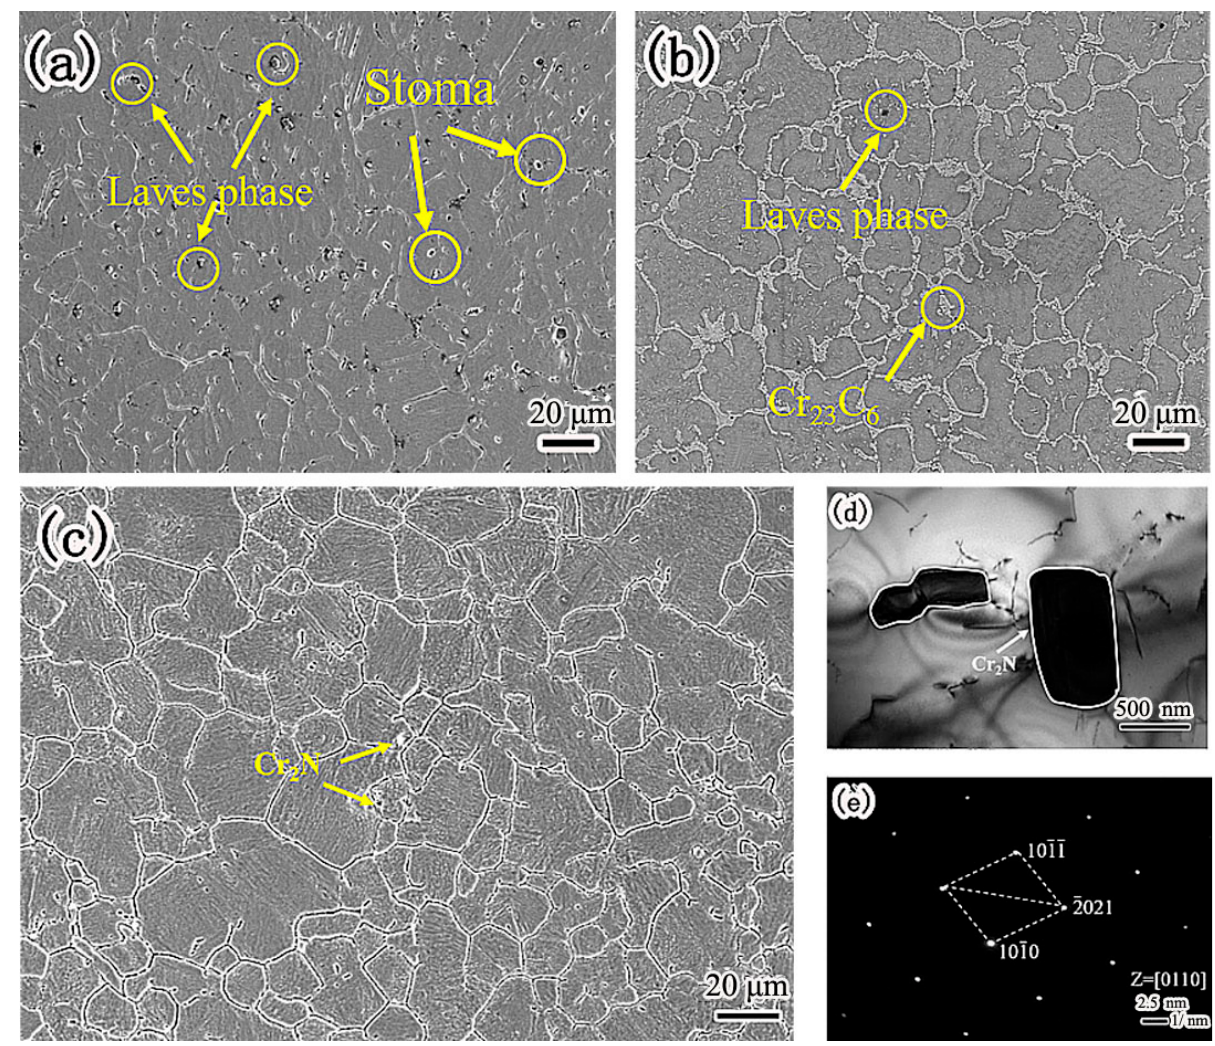
Figure 2. The microstructure of nitrogen ‐ containing low ‐ nickel weld cladding. ( a ) 1 nitrogen ‐ containing low ‐ nickel weld cladding precipitates; ( b ) 2 nitrogen ‐ containing low ‐ nickel weld cladding precipitates; ( c ) 3 nitrogen ‐ containing low ‐ nickel weld cladding precipitates; ( d ) Bright field image; ( e ) Diffraction spot. Table 3. The chemical composition of the precipitated phase of weld cladding (at %).